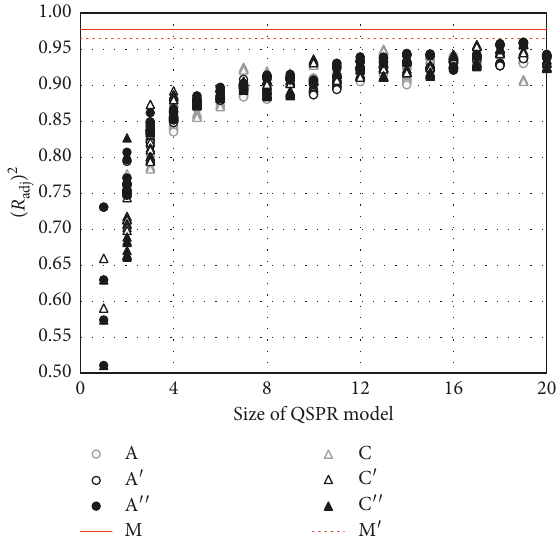
2 values characterizing a variety of Figure 9: Distributions of R adj ) ( QSPR models predicting the HB Hansen solubility parameter based on PaDEL descriptors or factors resulting from MARSplines models. Notation is the same as in Figure